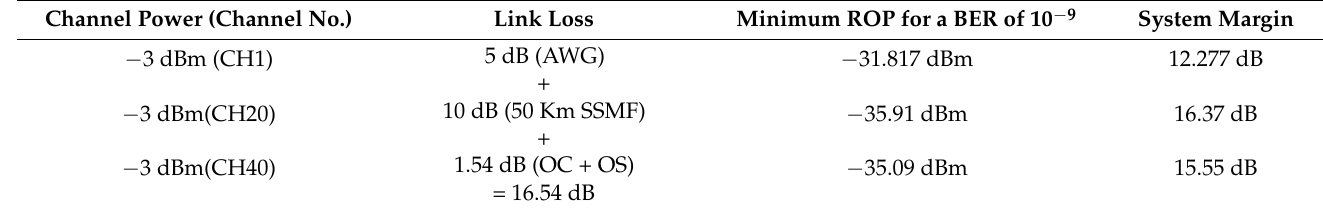
Table 6. System margins of the protection scheme for ROA 2